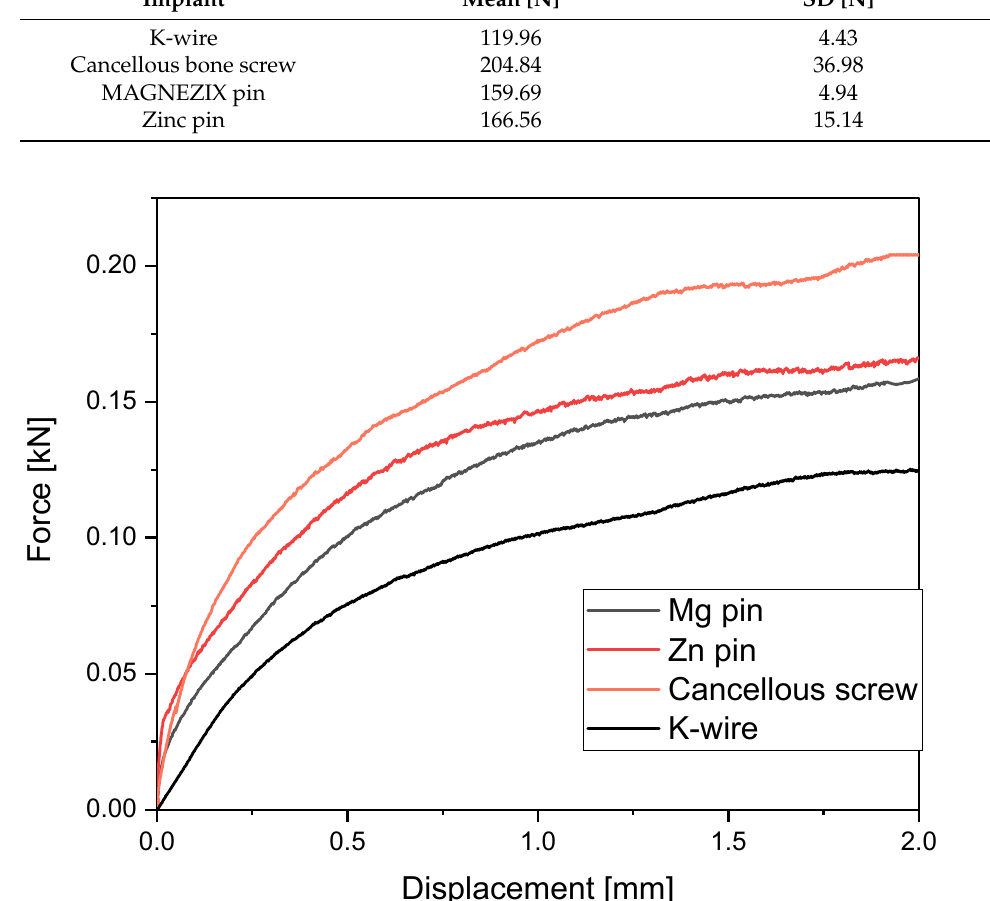
Table 2. Maximum forces measured in shear testing with mean and standard deviation (SD). Implant Mean [N] K-wire